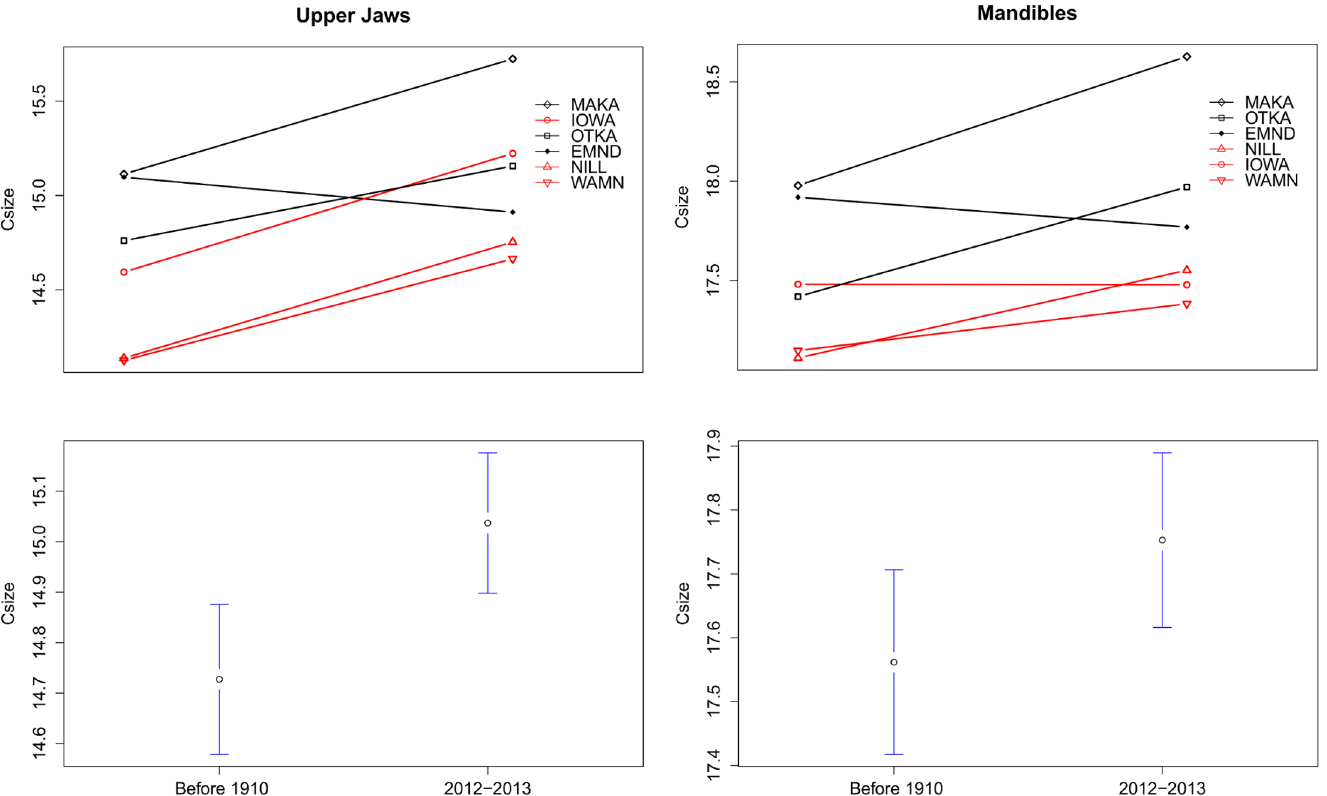
Fig 5. Size differences in mouse upper jaws and mandibles. All data depict average centroid size, which is calculated using all landmarks included in the morphometric analysis. Figures depict mandible and upper jaw size differences by location and year. Site abbreviations and sample sizes are as in Table 1. Sites with greater than or equal to 75% corn-soybean cover in the landscape are depicted in red, while sites with less than or equal to 33% corn-soybean cover are depicted in black. Bottom graphs illustrate the average size and 1 SE by time